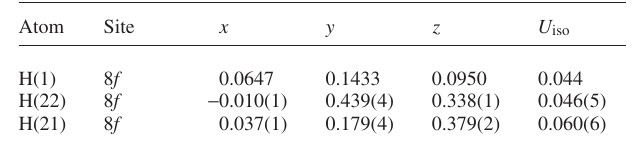
Table 2. Atomic coordinates and displacement parameters (in Å 2 )